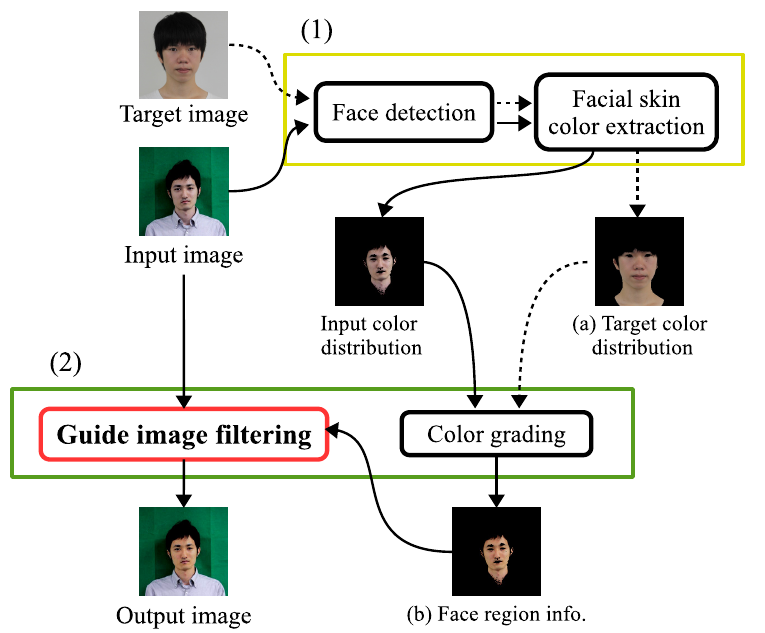
Figure 1. Flow chart of our